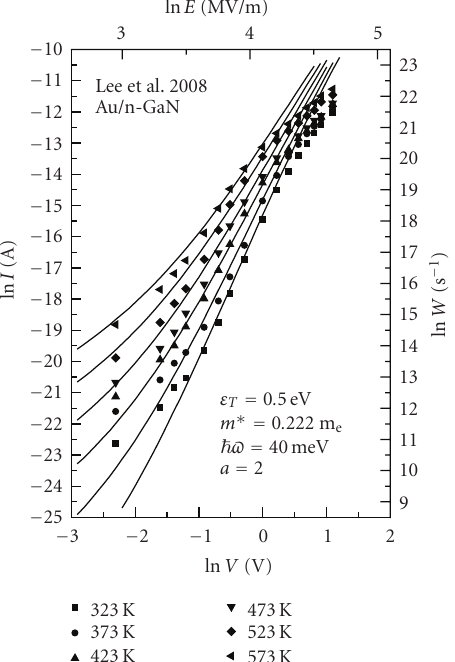
Figure 4: The I-V characteristics of Au/n-GaN nano-Schottky diode represented from Figure 2 [19] (symbols) fitted to theoretical W ( E , T ) against E dependences (solid curves). Parameters for computation: ε T = 0 . 5 eV, m ∗ = 0.222 m e , (cid:2) (cid:5) = 40meV, a = 2 . 0.